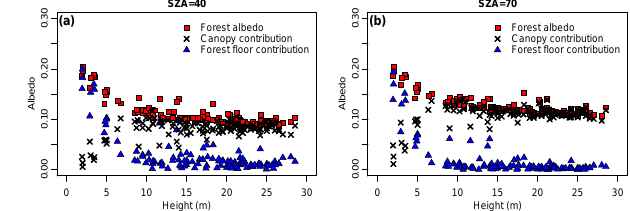
Figure 7. Canopy and forest floor contributions to forest black-sky albedo as function of tree height. Canopy contribution was obtained by assuming black soil in the simulation. Forest floor contribution was obtained by subtracting the canopy contribution from the total forest albedo. The data shown are from Norway spruce dominated forests in